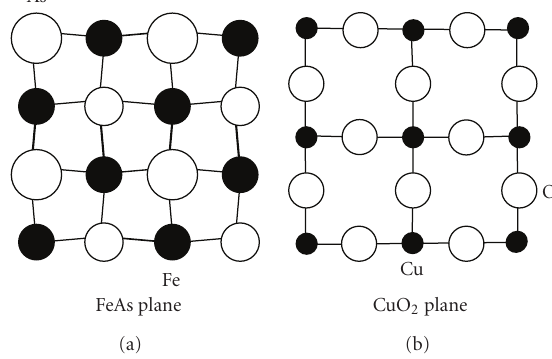
Figure 1: In-plane structure of the conducting layer in LaFeAsO 1 − x F x (a) and La 1 − x Sr x CuO 4 (b). Use of polarization dependence ( E // ab ) XAS measurement can probe the planar local lattice projected onto the ab